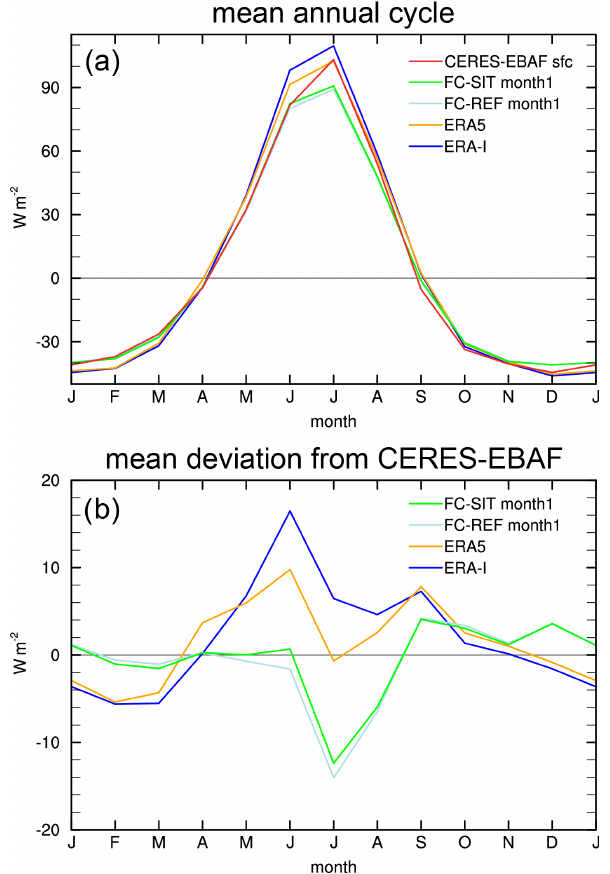
Figure 10. (a) Mean annual cycle of surface net radiation, Rad S (Wm − 2 ), over the ocean area north of 70 ◦ N from ERA-I, ERA5, FC-REF (lead month 1), FC-SIT (lead month 1) and CERES-EBAF and (b) mean deviation of Rad S from CERES-EBAF for FC-REF, FC-SIT, ERA-I and